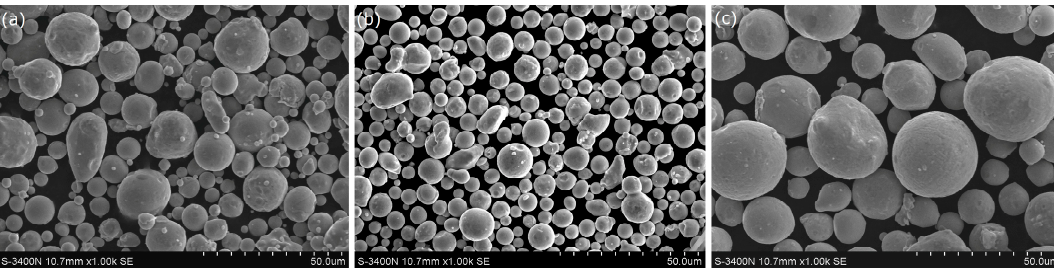
Figure 2. SEM image of three particle size distribution of SS316L powders ( a ) raw powder, ( b ) fine powder and ( c ) coarse powder.